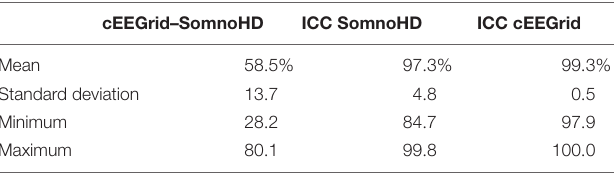
Column 2: concordance rates between cEEGrid and SomnoHD data obtained by one scorer; columns 3 and 4: inter-rater concordances for SomnoHD and cEEGrid,